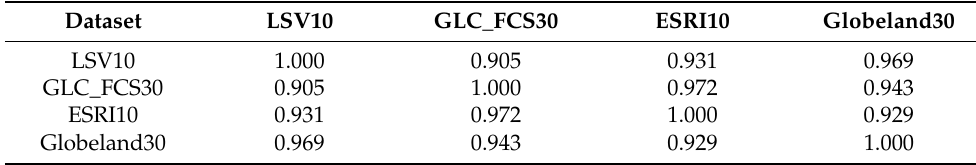
Figure 3. LULC composition of the study area. Table 4. Correlation between different LULC